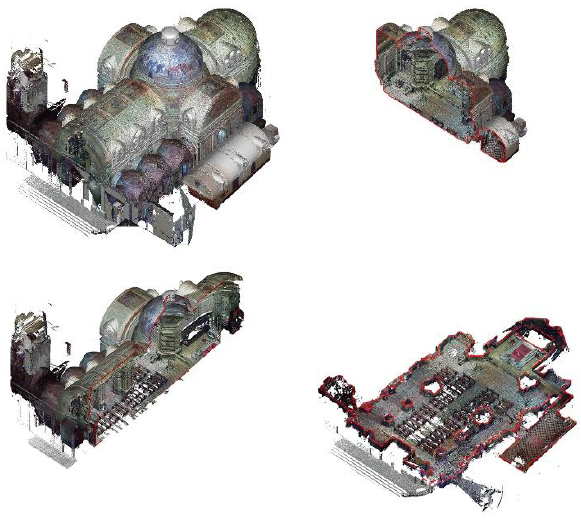
Figure 2 . TLS point cloud. Section operations with horizontal and vertical planes for the extraction of orthophotos.